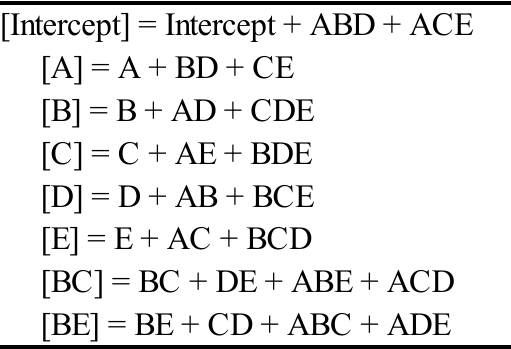
Figure 2. Alias structure for a 2 5 − 2 .